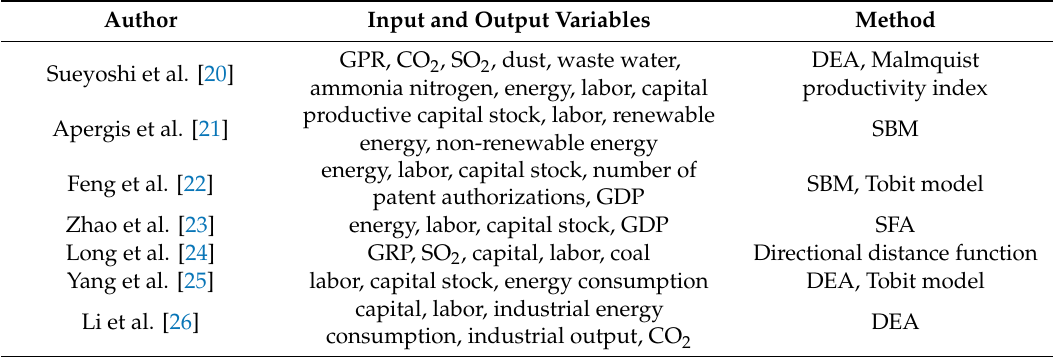
Table 1. Research on total factor energy e ffi